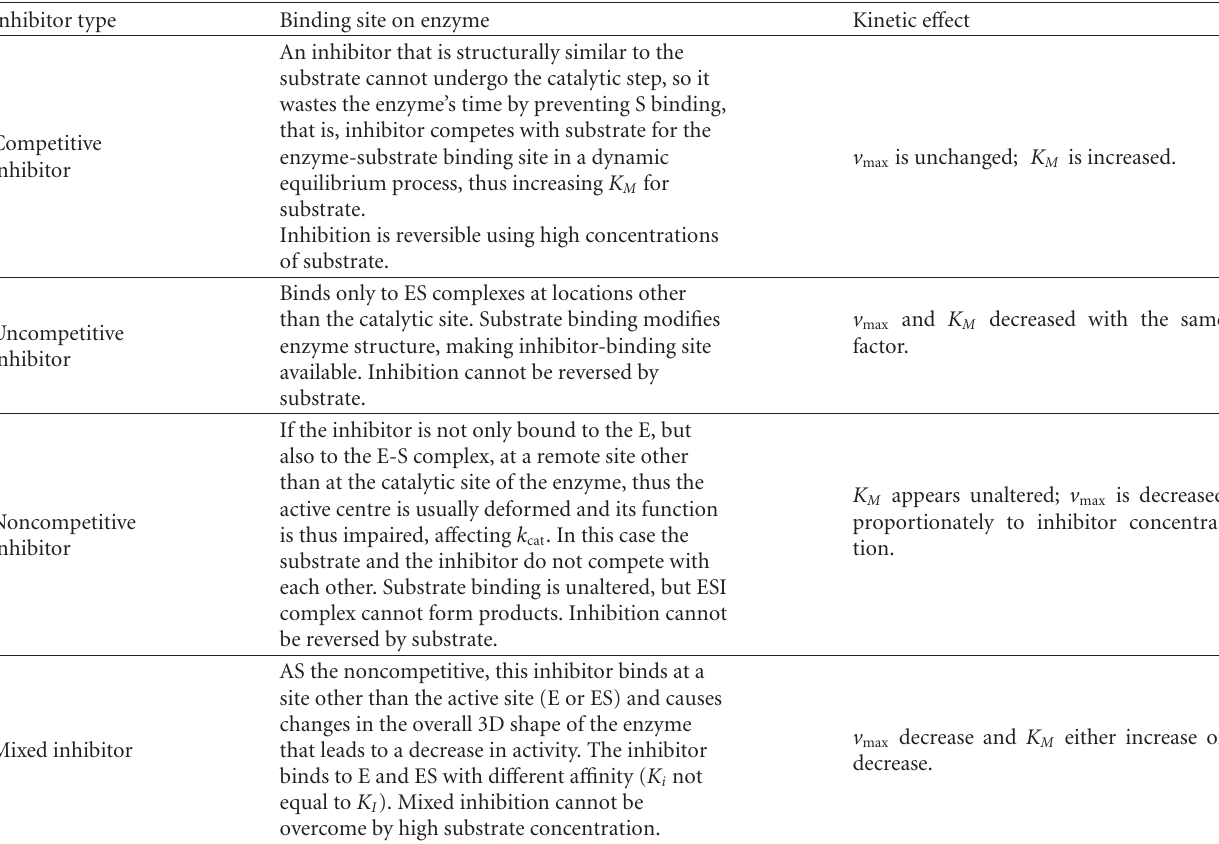
Table 2: Type of